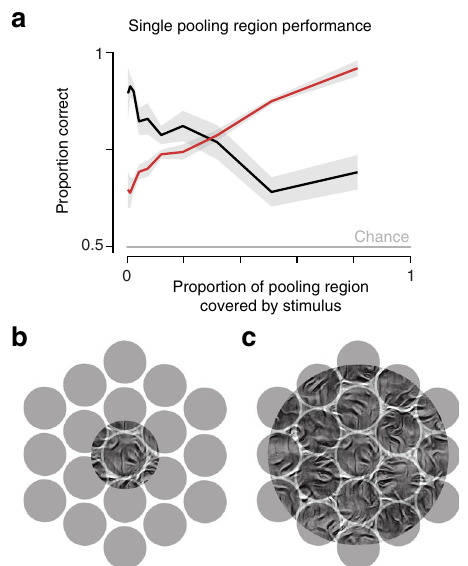
Fig. 5 Model discrimination performance, computed for a single pooling region, varies depending on the portion covered by the stimulus. a Average family (red) and sample (black) discrimination performance of single pooling regions as a function of the proportion covered by the stimulus. Simulations include pooling regions that are larger than the stimulus aperture, as well as those that are offset so as to extend beyond the stimulus border. Shaded region indicates mean ± SEM across performance over all geometries. b Schematic depiction of pooling region coverage for a small stimulus. c Schematic depiction of pooling region coverage for a large stimulus (note: example pooling regions in b and c are depicted in stylized form, as nonoverlapping circular discs — actual model pooling regions are smoothly overlapping and polar-separable with eccentricity-dependent sizes.) Source data are provided as a Source Data fi